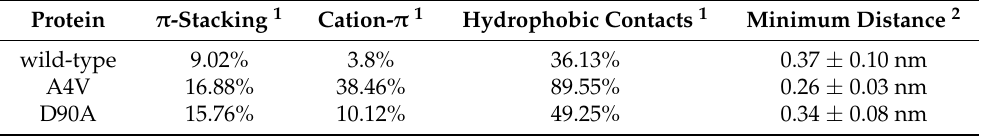
Table 1. Interactions between SBL-1 and residue